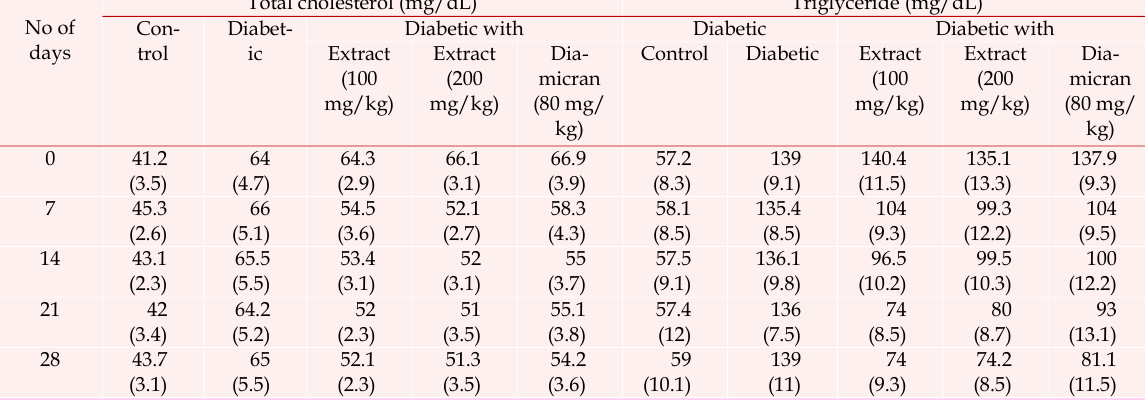
Effect of C. lancifolius extract on total cholesterol and triglycerides level in alloxan-induced diabetic rabbits